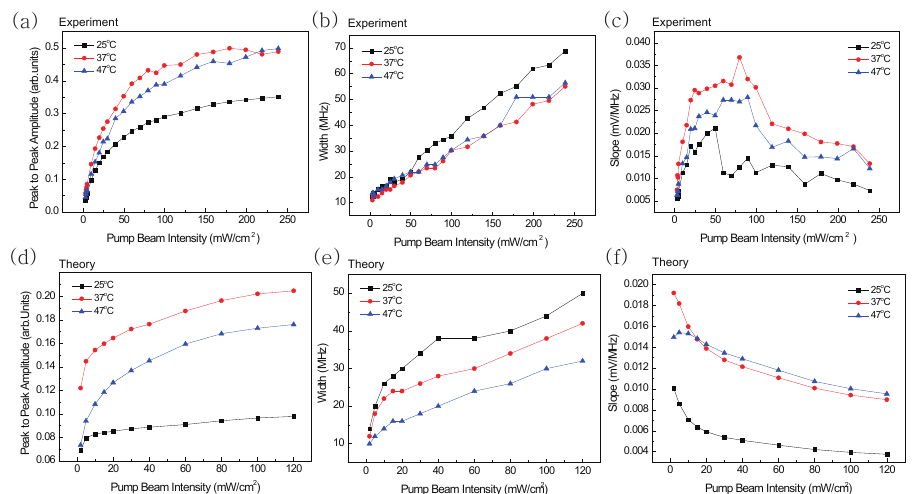
F e = 3 transition line on the change of Figure 3. Dependence of the PS signal of 87 Rb F g = 2 → pump beam intensity (1 mW/cm 2 to 250 mW/cm 2 ) under three different vapor cell temperatures. The probe beam intensity I pr was 1.6 mW/cm 2 . Further, ( a – c ) show the experimental (theoretical) results of the amplitude, width, and slope of the PS signal, respectively, whereas ( d – f ) show the corresponding theoretical results.